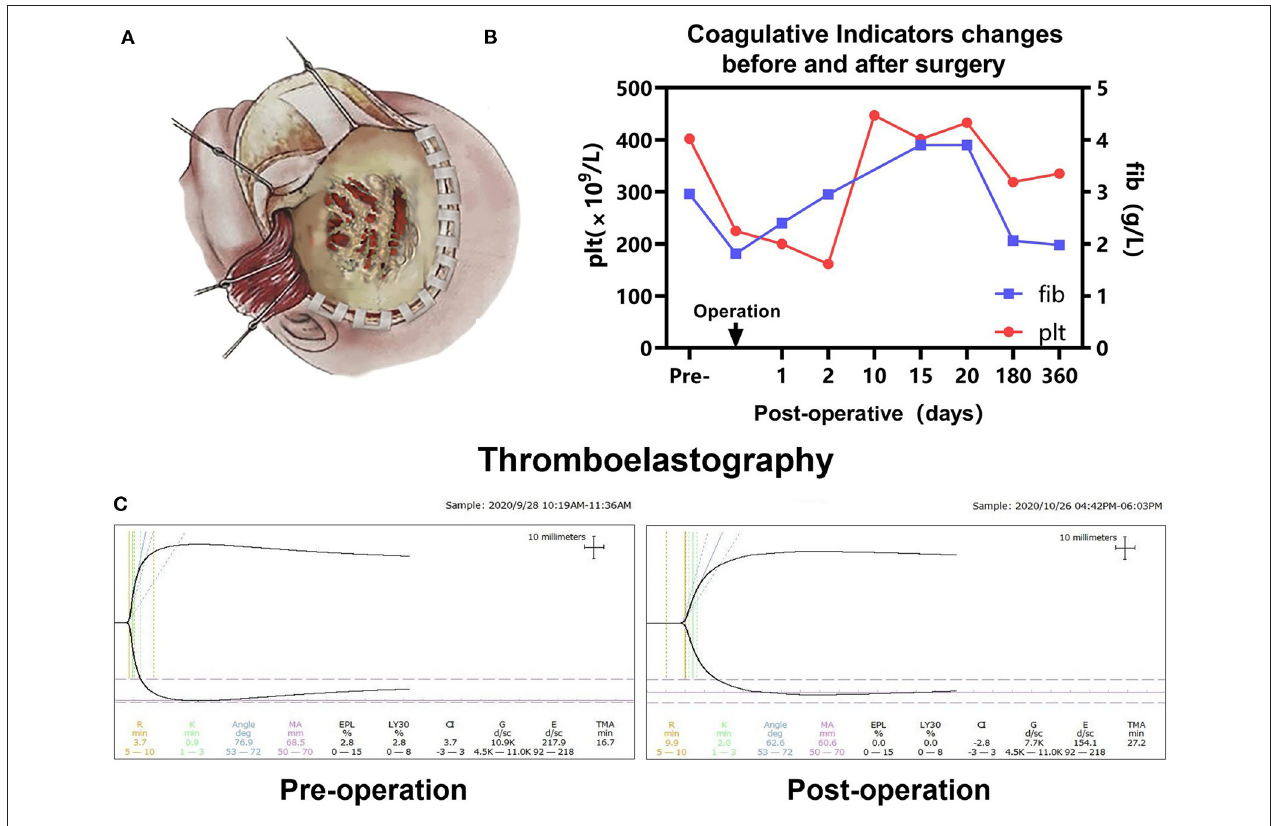
FIGURE 2 | (A) Schematic diagram of the left frontotemporal craniotomy approach in our case, the seeping blood, worm-like changes were observed on the surface of the skull, the skull was invaded seriously by tumor and getting thinner. (B) Pre- and postoperative platelet (Plt) and fibrinogen (Fib) were monitored. (C) Pre- and postoperative thromboelastography revealing that no coagulopathy was